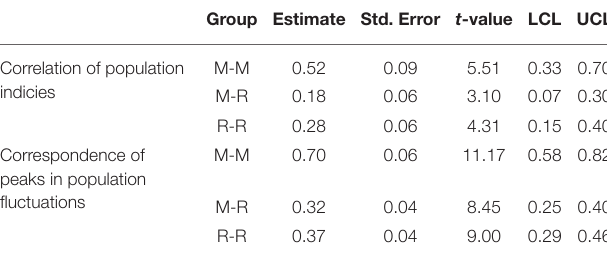
TABLE 4 | Estimates for mean Spearman correlation ( r ) and proportion of corresponding peaks for species-species comparisons between migrant species (M-M, n = 10), between migrant and resident species (M-R; n = 45), and between resident species pairs (R-R; n =